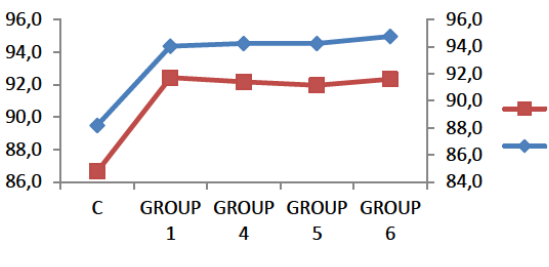
Figure 5: Classification accuracy for all TD